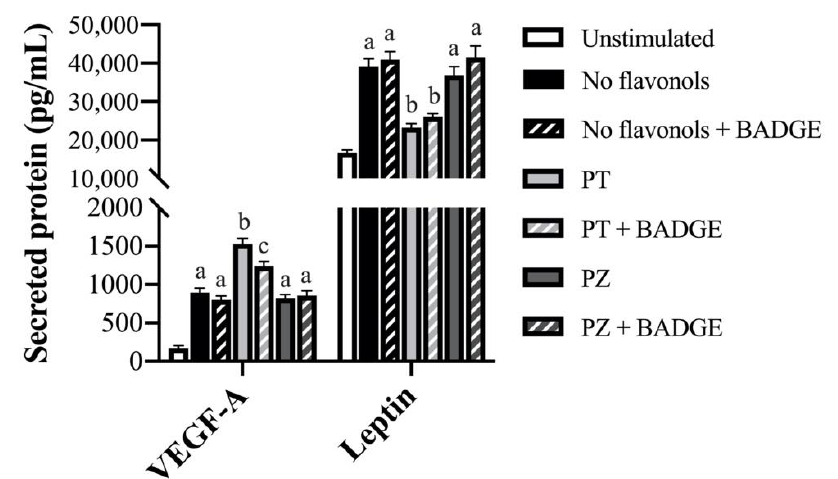
Figure 3. Secreted protein levels of angiogenic factors (vascular endothelial growth factor (VEGF)-A